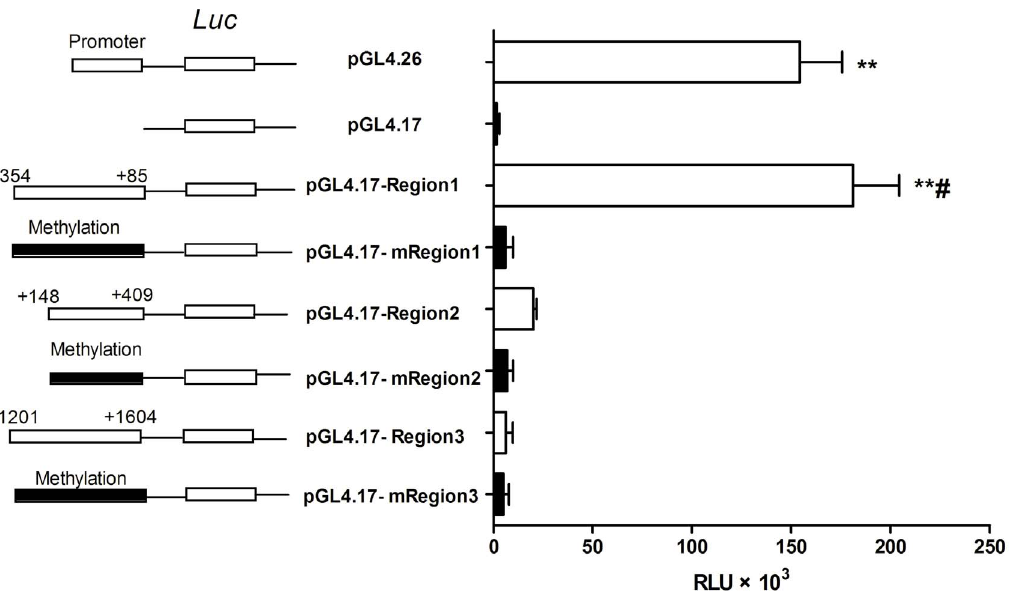
Figure 4. Methylation effects on transcriptional activity of the OCTN2 promoter in a luciferase reporter assay. Constructed pGL4.17 luciferase vector containing unmethylated and methylated promoter regions were transfected into COS-7 cells with the pRL-TK control vector. Forty- eight h later, the cells were washed and assayed for luciferase activity. Relative luciferase activity was measured in triplicate wells. Data presented represent the mean 6 S.D. of three independent experiments. Significant difference from the treatment group of pGL4.17 is denoted with asterisks (*, p , 0.05; **, p , 0.01). Significant difference from the group of methylated region in the same region is denoted with a pound sign ( # , p , 0.05).